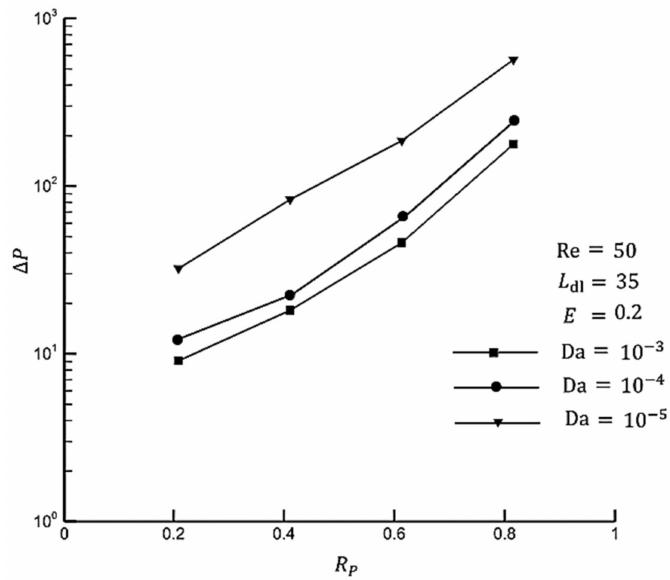
Figure 19. Effect of porous medium thickness on pressure drop in eccentric